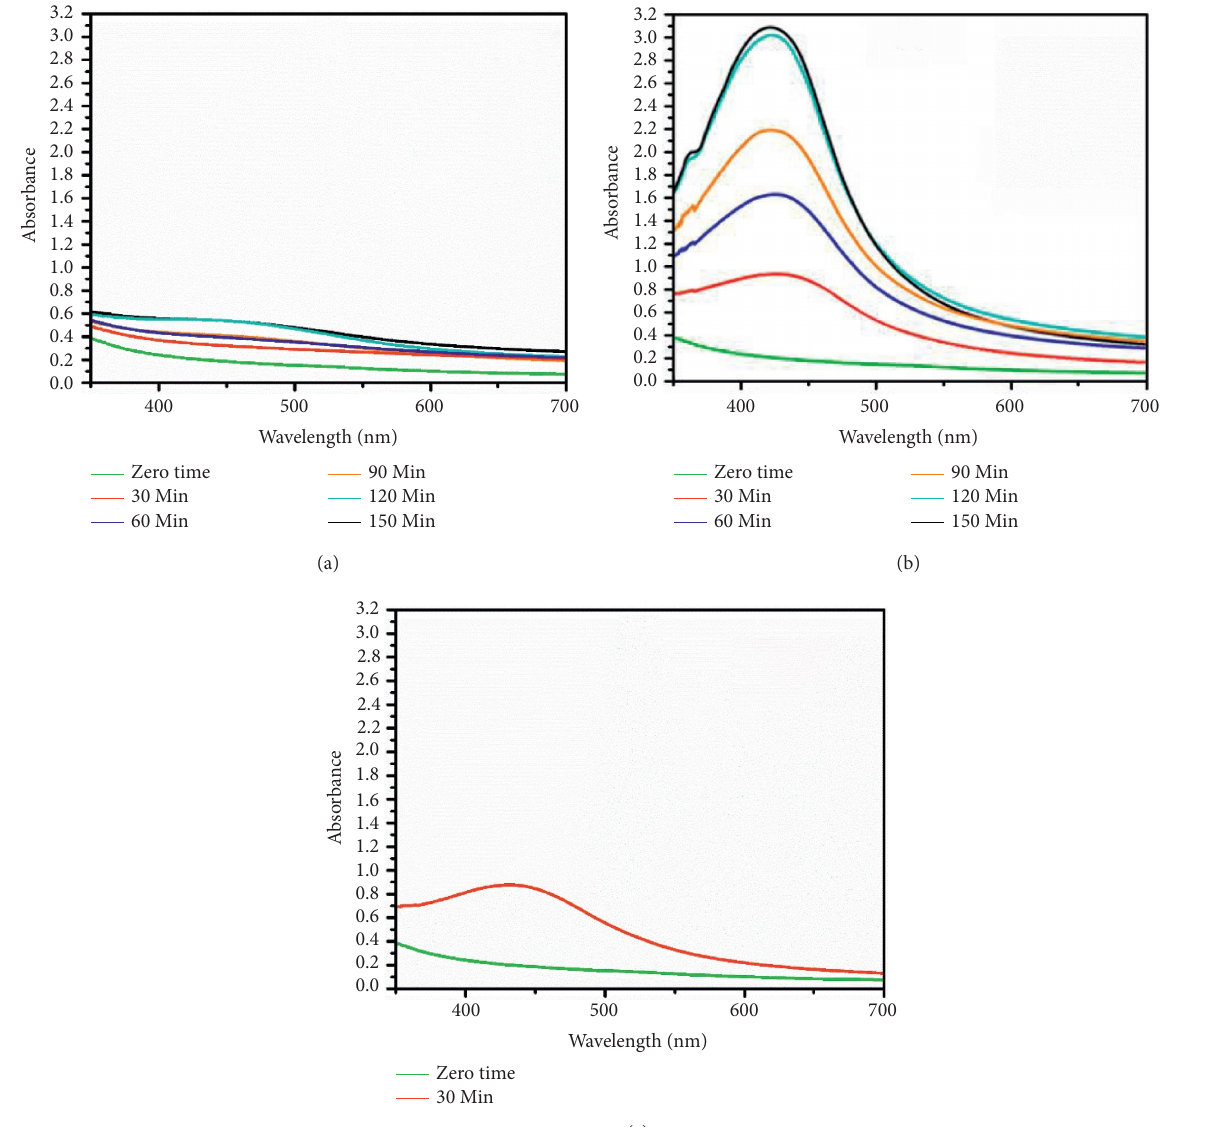
Figure 2: UV-vis absorption spectra of the silver nanoparticles biosynthesized by Cystoseira myrica at different temperature, (a) T � 25 ° C, (b) T � 50 ° C, (c) T � 75 ° C, and at different time intervals minutes (zero time, 30, 60, 90, 120, and